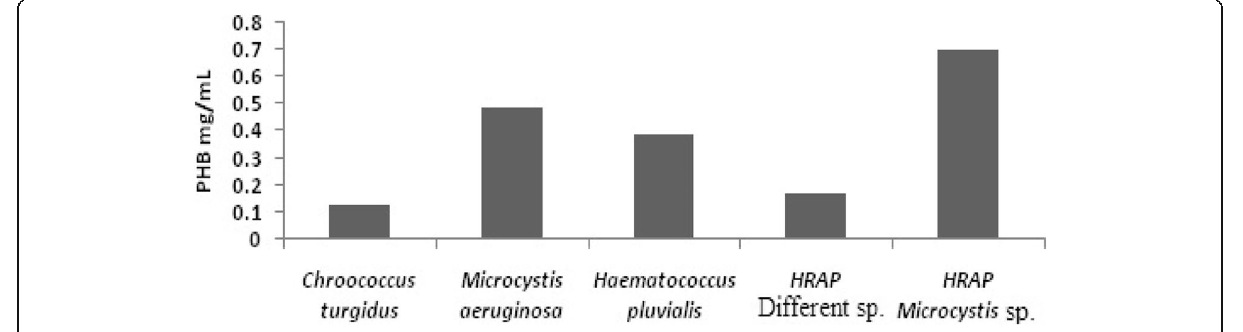
Fig. 1 Polyhydroxybutrate concentration in different microalgal